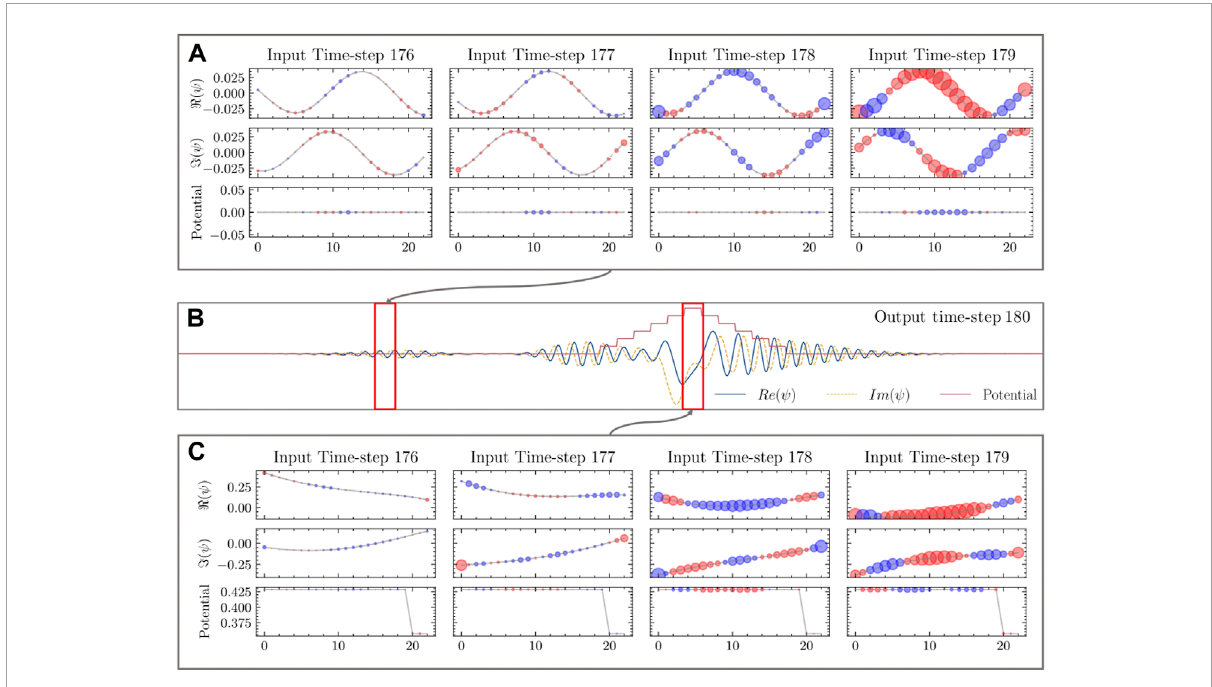
FIGURE 7 Model Interpretability. (A) , Direct gradients calculated for a freely dispersing quantum wave (far from any potential barrier). Red circles denoting positive direct-gradient values, and with blue circles denoting negative values. (B) , Two wave functions: one far from any potential barrier (left); second interacting with a step pyramid-shaped potential barrier (right). (C) , Direct gradients calculated for a quantum wave interacting with a potential